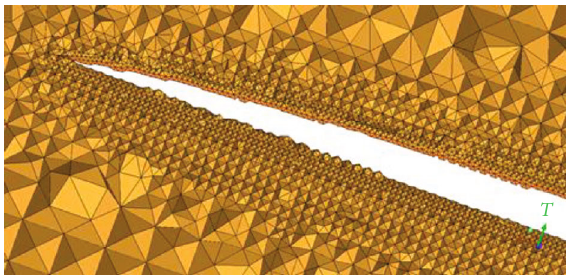
Figure 2: Global grid division.